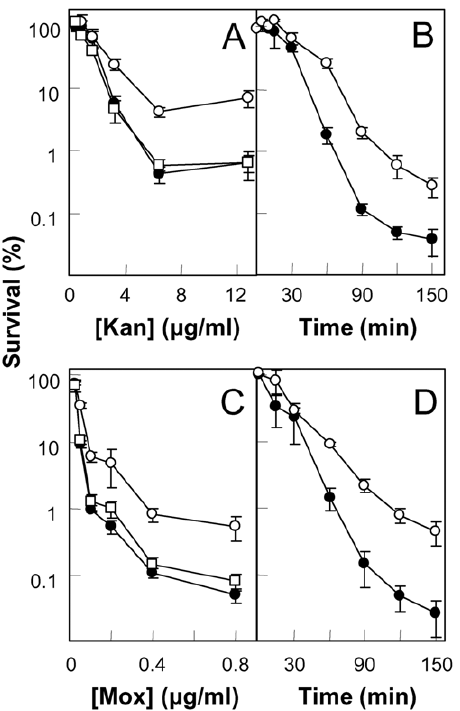
Figure 1. Effect of ndoA deficiency on bacterial survival after antimicrobial treatment. Wild-type strain (BD630, filled circles) and its D ndoA mutant (3169, open circles) were treated with the indicated concentrations of kanamycin (Kan) for 1 hr (panel A), 10-times MIC (4 m g/ml) kanamycin for the indicated times (panel B), the indicated concentrations of moxifloxacin (Mox) for 2 hr (panel C), and 16-times MIC (0.4 m g/ml) moxifloxacin for the indicated times (panel D). Results with a complemented D ndoA mutant strain (3322) containing a single copy of the intact ndoAI-ndoA operon inserted at the chromosomal amyE locus are shown in panels A and C (open squares). Percent survival was determined as in Methods. Error bars indicate standard deviation; similar results were obtained in replicate (Fig. 3B). At moderate irradiance intensity (0.2 mW/cm 2 ), the